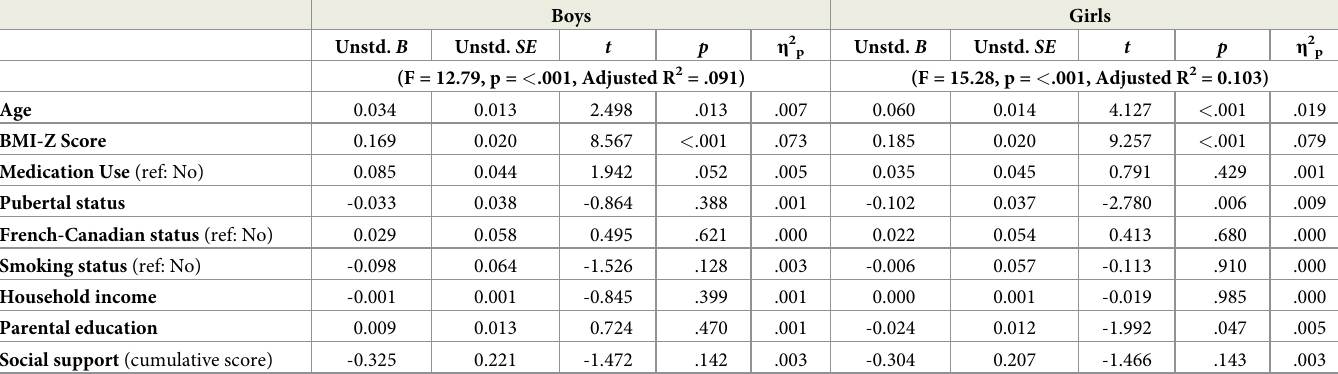
Table 3. Prediction model by sex.